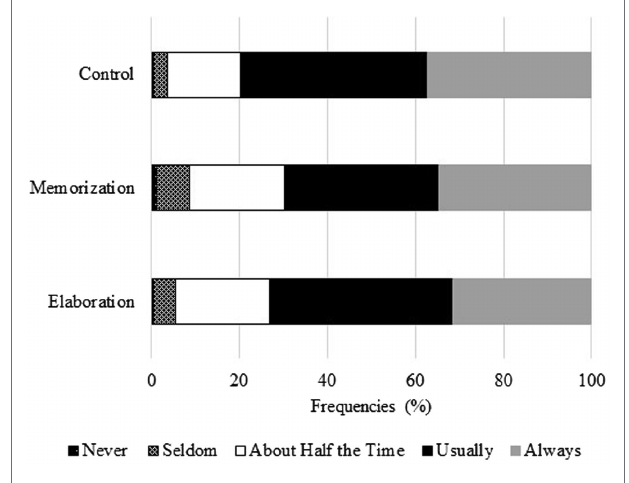
Figure 2 indicates the standardized estimates on regression paths in the model. Positive coefficients show positive directions, and negative coefficients starting from knowledge acquisition indicate a negative effect on the memorization strategy. All paths are significant at p < 0.05.